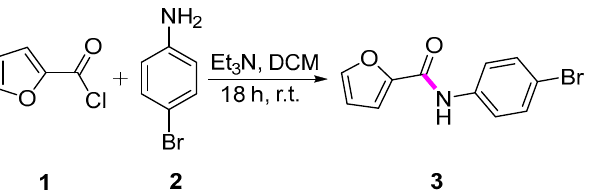
Scheme 2. Synthesis of N -(4-arylphenyl)furan-2-carboxamide ( 5a-i